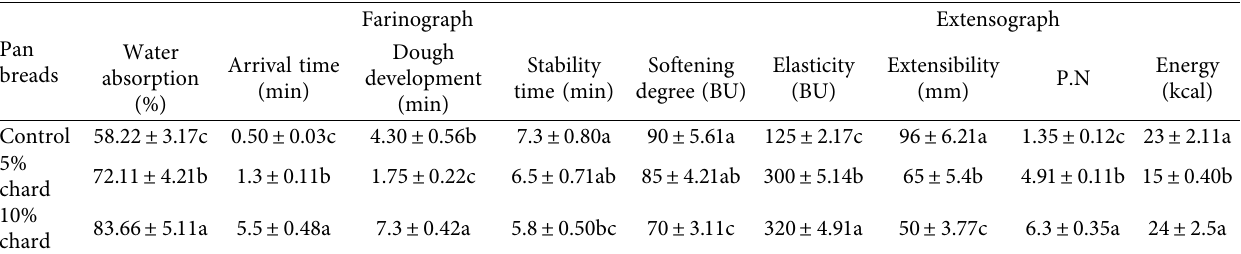
Table 5: Rheological properties of chard pan bread dough.